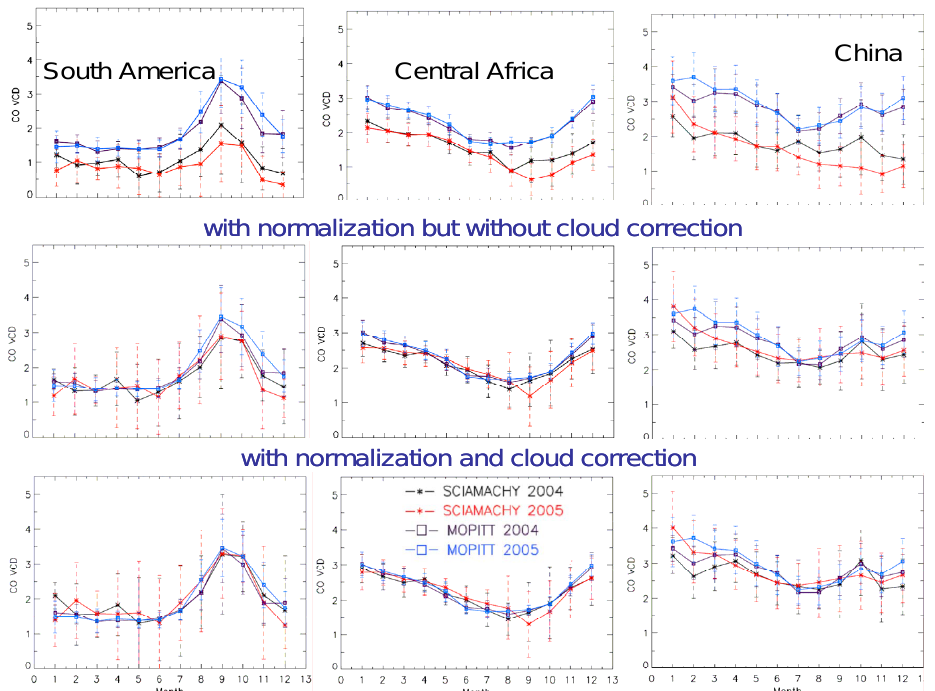
Fig. A4. Comparison of the monthly mean CO VCD (in units of 10 18 moleccm − 2 ) derived from coincident measurements of SCIAMACHY and MOPITT for selected regions. In the top panel uncorrected SCIAMACHY CO VCDs are shown, in the middle panel, SCIAMACHY CO VCD after normalisation are shown, and in the bottom panel SCIAMACHY CO VCDs after additional cloud correction are shown (the same data as in Fig.